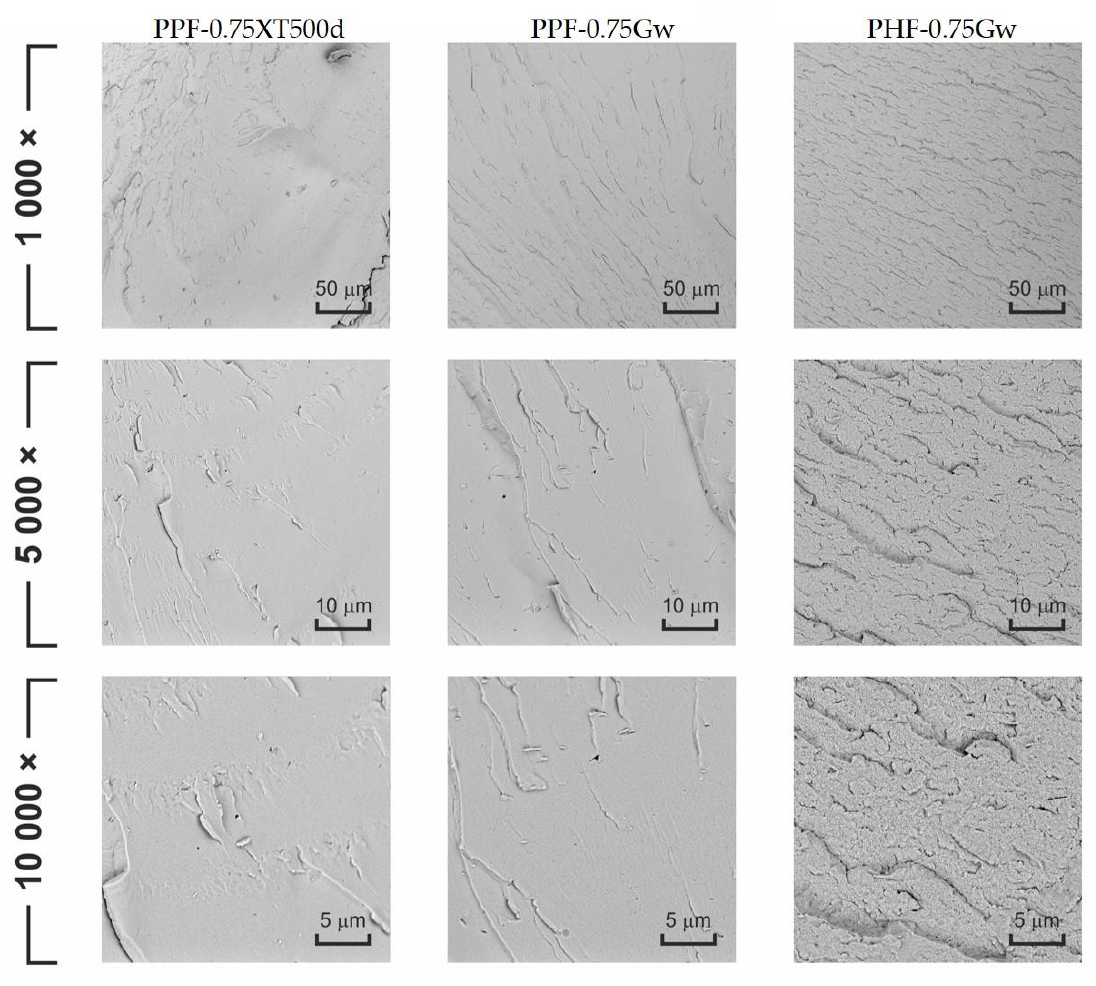
Figure 11. SEM images of the prepared composite products at several magnification.